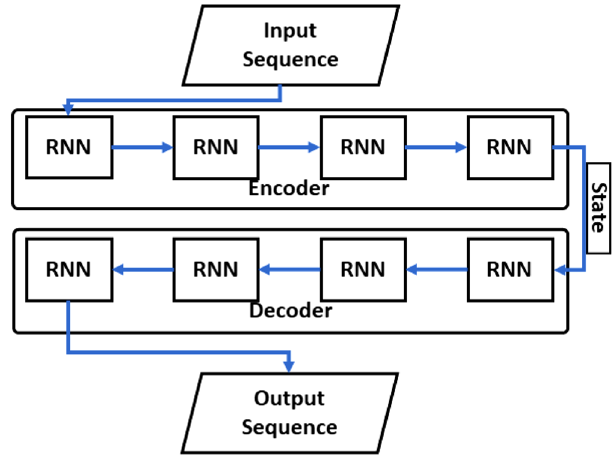
Figure 5. Architecture of encoder–decoder.